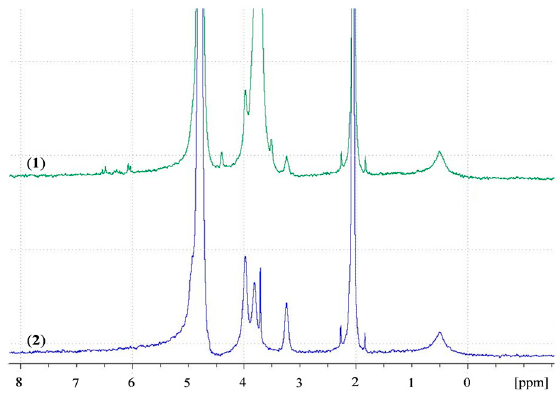
Figure 7. 1 H NMR spectra of ( 1 ) ACS nanoparticles; ( 2 ) CS nanoparticles in D 2 O.